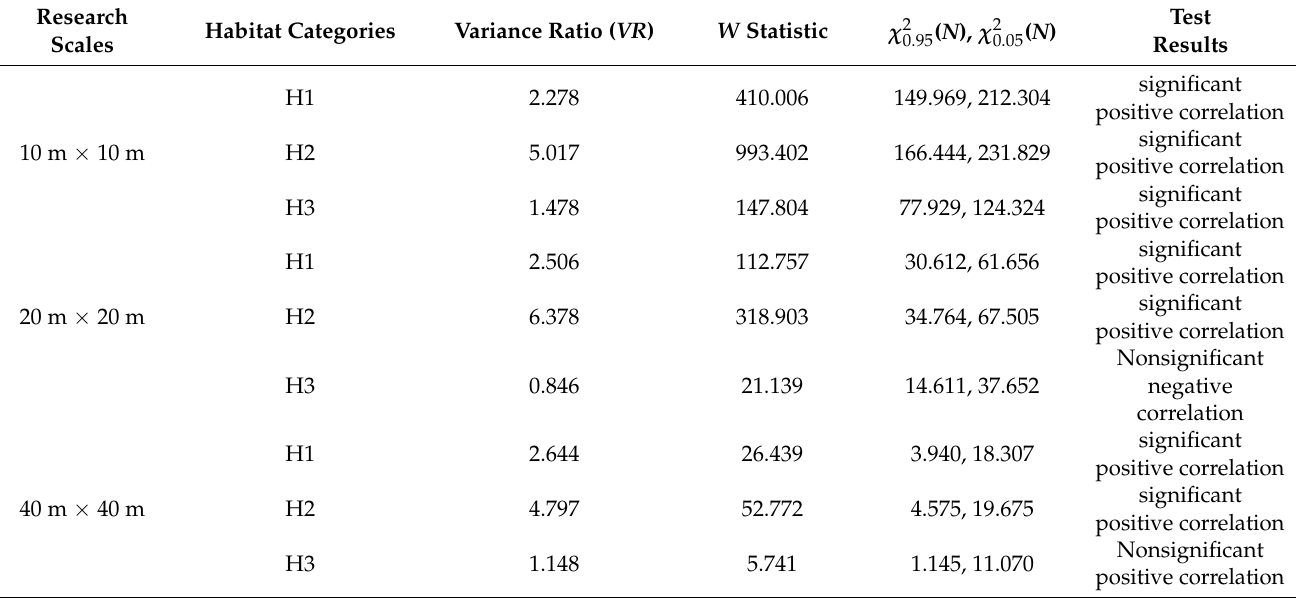
Table 2. The overall interspecific associations at community level of three scales and